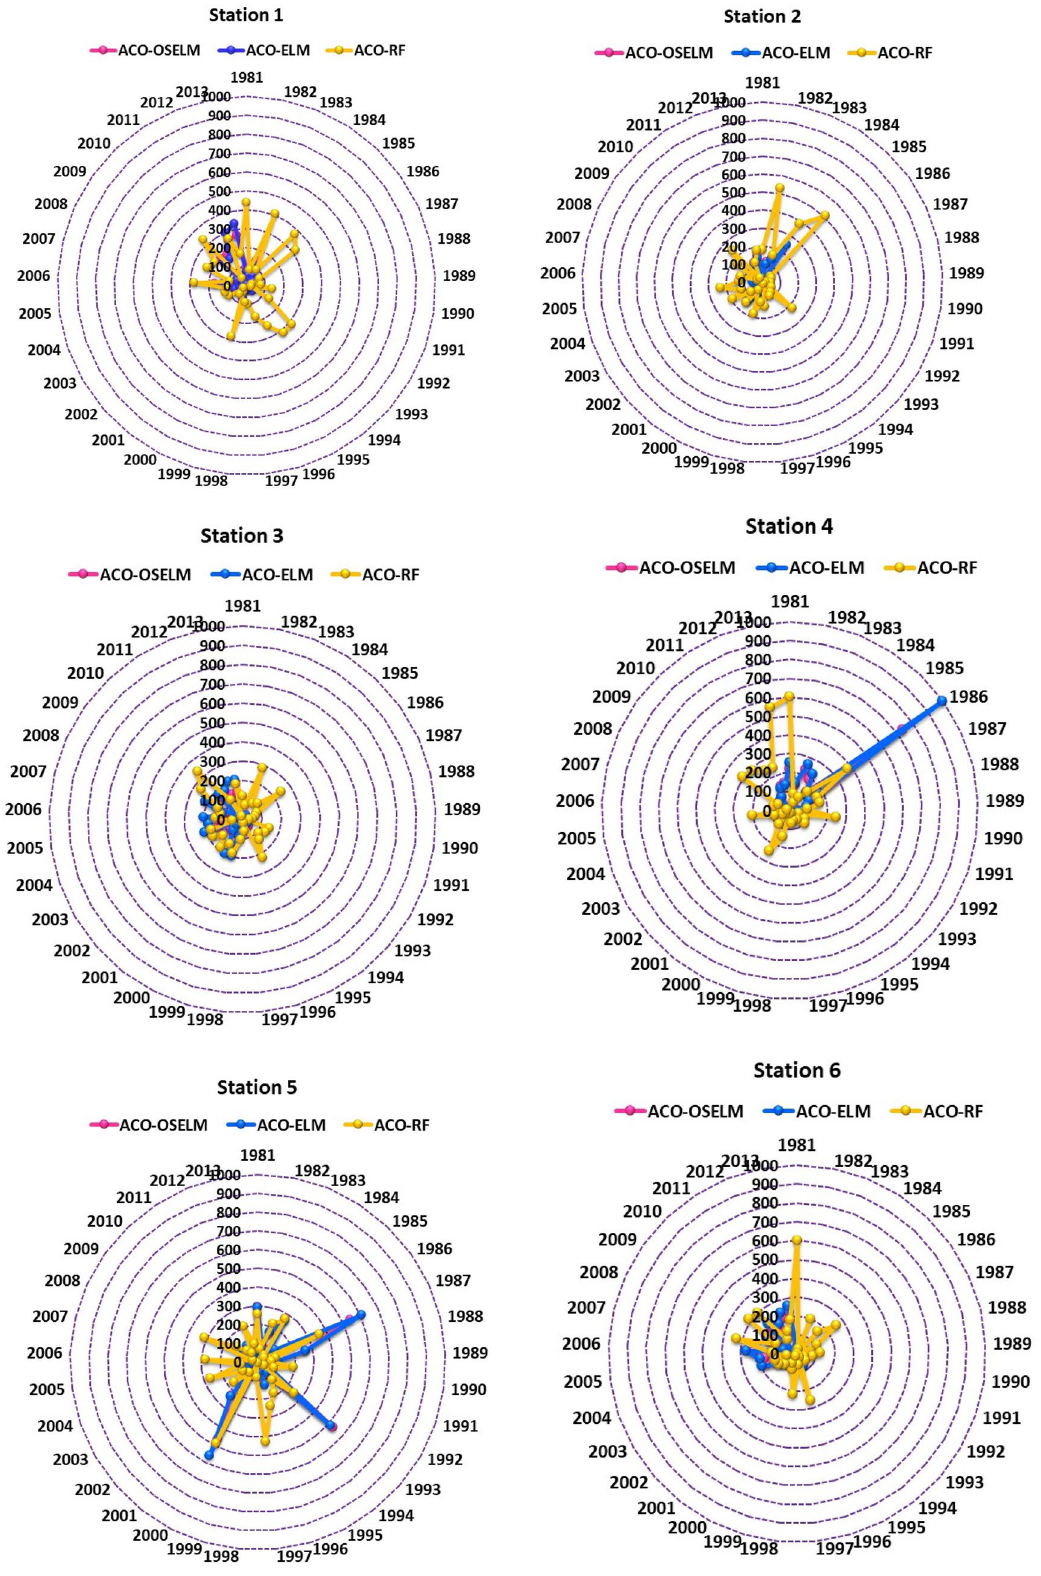
Figure 11. Polar plots showing the prediction error |PE| in each year generated from the ACO-OSELM versus ACO-ELM and ACO-RF models in predicting wheat yield for all